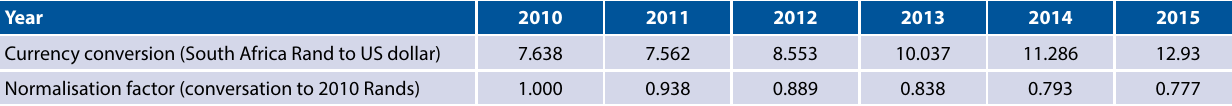
Table 2. Values for exchange rates and normalisation factors